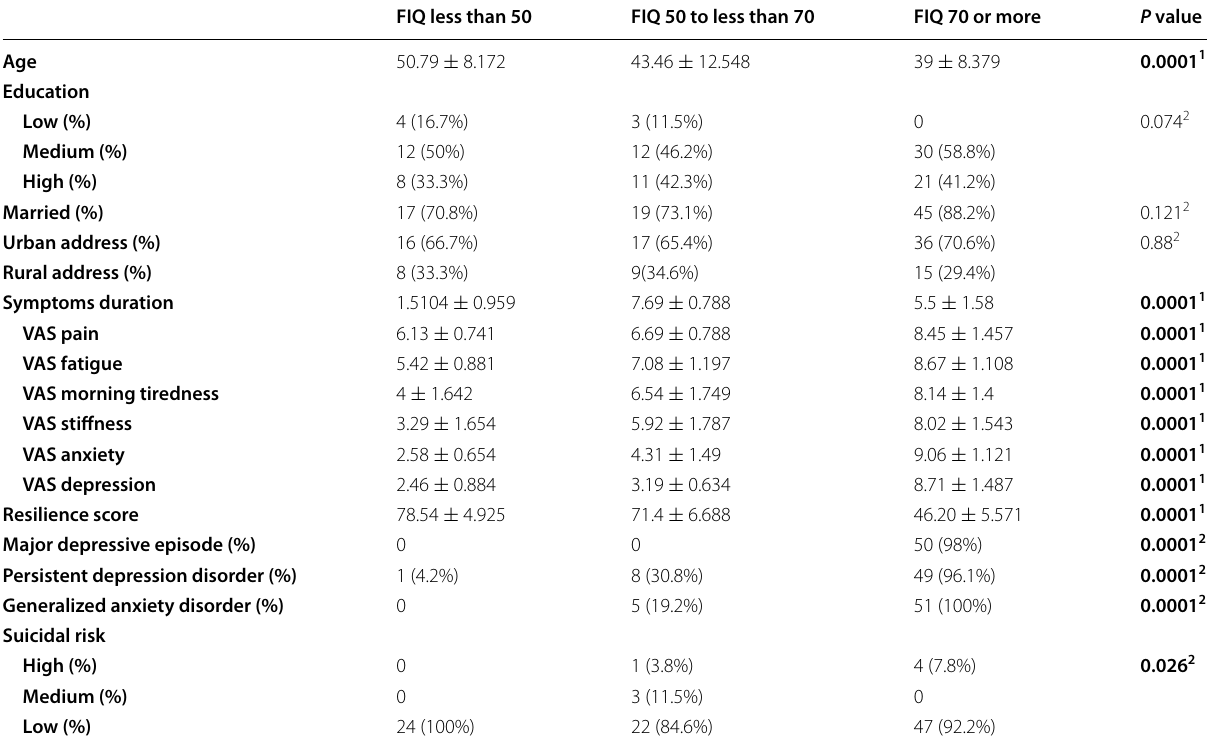
All variables are expressed as mean FIQ Fibromyalgia Impact Questionnaire, VAS =